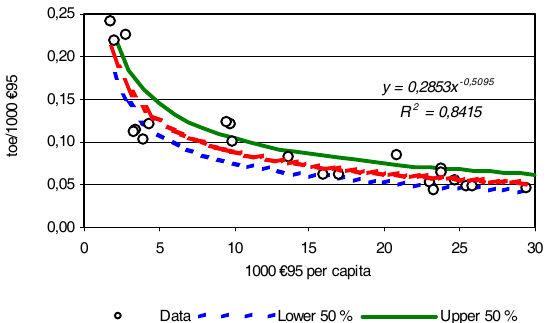
Fig 6. Dependence function of intensity consumption of petroleum products in EU countries on GDP per capita